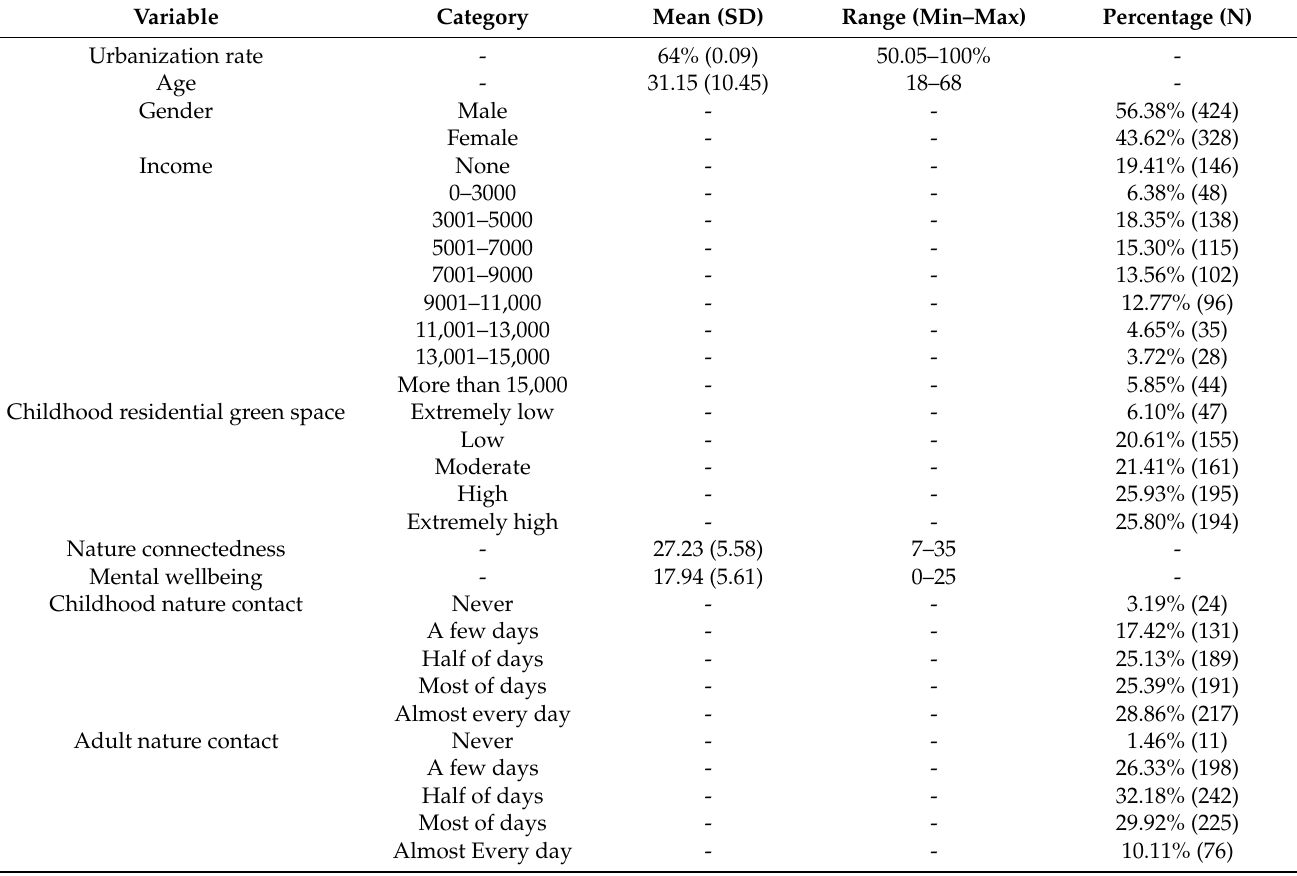
Table 1. Participant characteristics ( n =